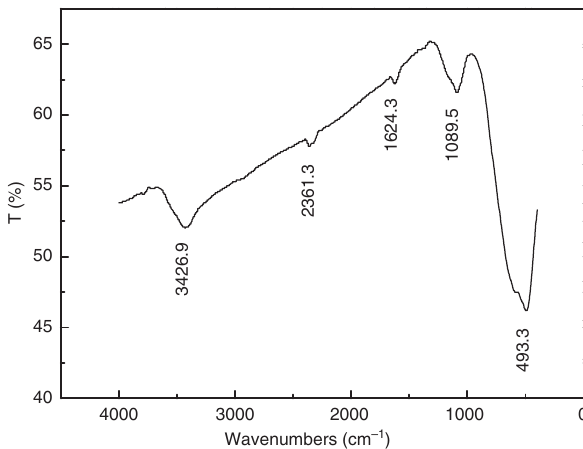
Figure 3: Fourier transform infrared (FT-IR) spectra of high titanium slag.